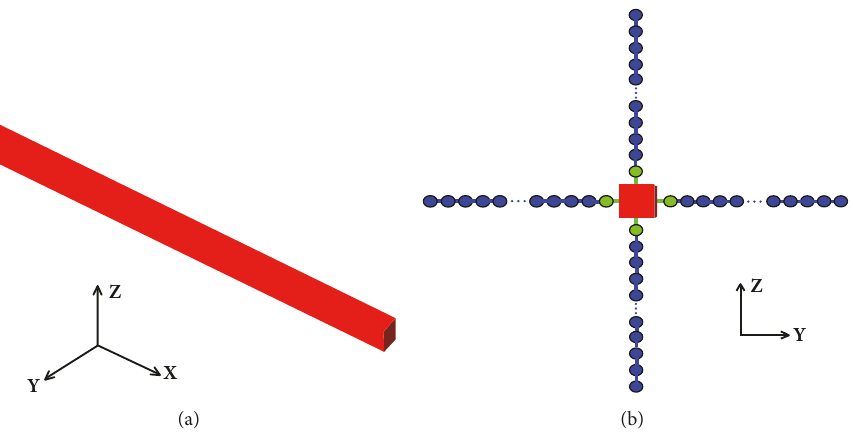
Figure 1: (a) Scheme of one-dimensional nanorod with the long axis along the X -axis. (b) The sketch map of four typical polymer chains regularly grafted on four surfaces of the nanorod (this picture was viewed along the X -axis direction). The red parts represent the one- dimensional nanorod, the green sphere represents the segments grafted directly on nanorod, and the blue sphere represents the rest polymer